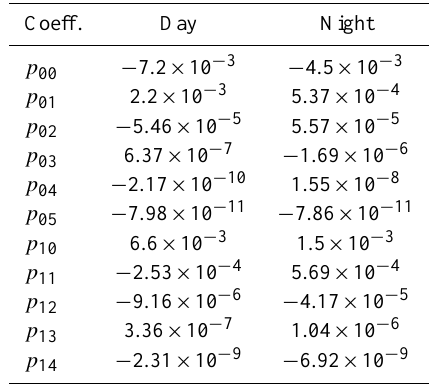
Table 5. Polynomial coefficients for mean backscatter profiles fit- ting (Eq. 9).